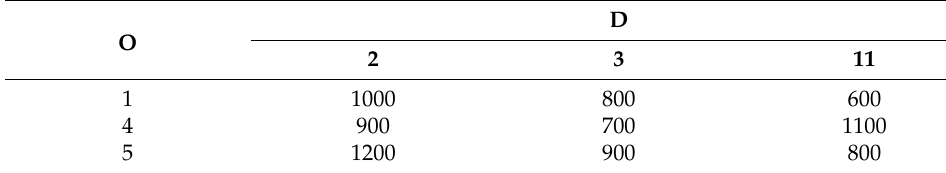
Table 3. Basic traffic demand between OD.